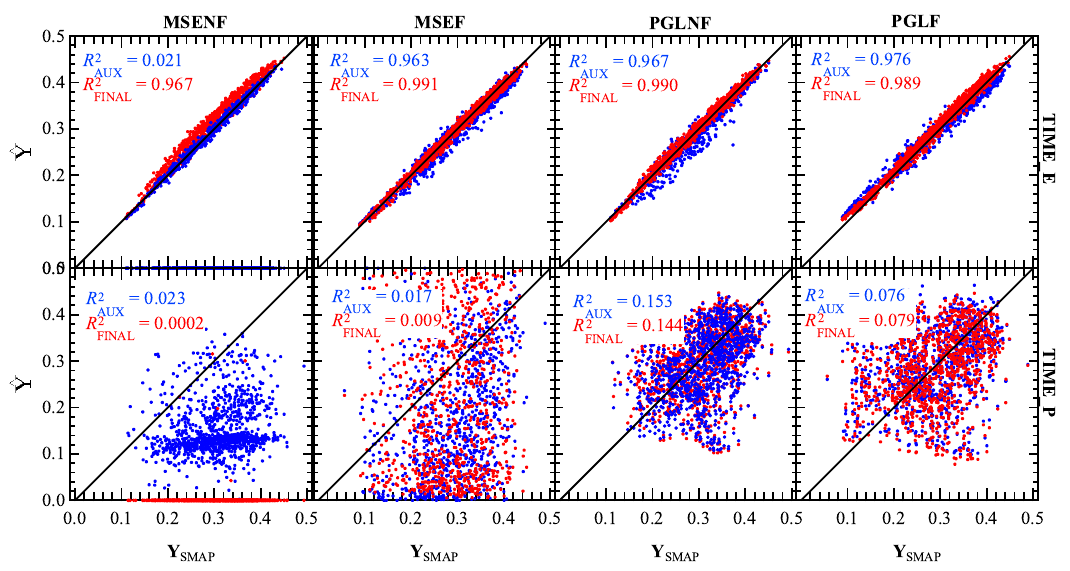
Figure 7. ELKR model results from the AUX (blue) and FINAL (red) outputs plotted vs. SMAP SM labels. Results are shown for the trained SNGLT model applied to ELKR test sets for the TIME_E (top; 1 January 2016–31 December 2018) and TIME_E (bottom; 1 January 2017–31 December 2019) time periods. Results are shown for all experiments (from left) SNGLT_MSENF, SNGLT_MSEF, SNGLT_PGLNF, and SNGLT_PGLF. The output with the highest accuracy is shown as the top layer in each subplot, highlighting the effectiveness of each loss